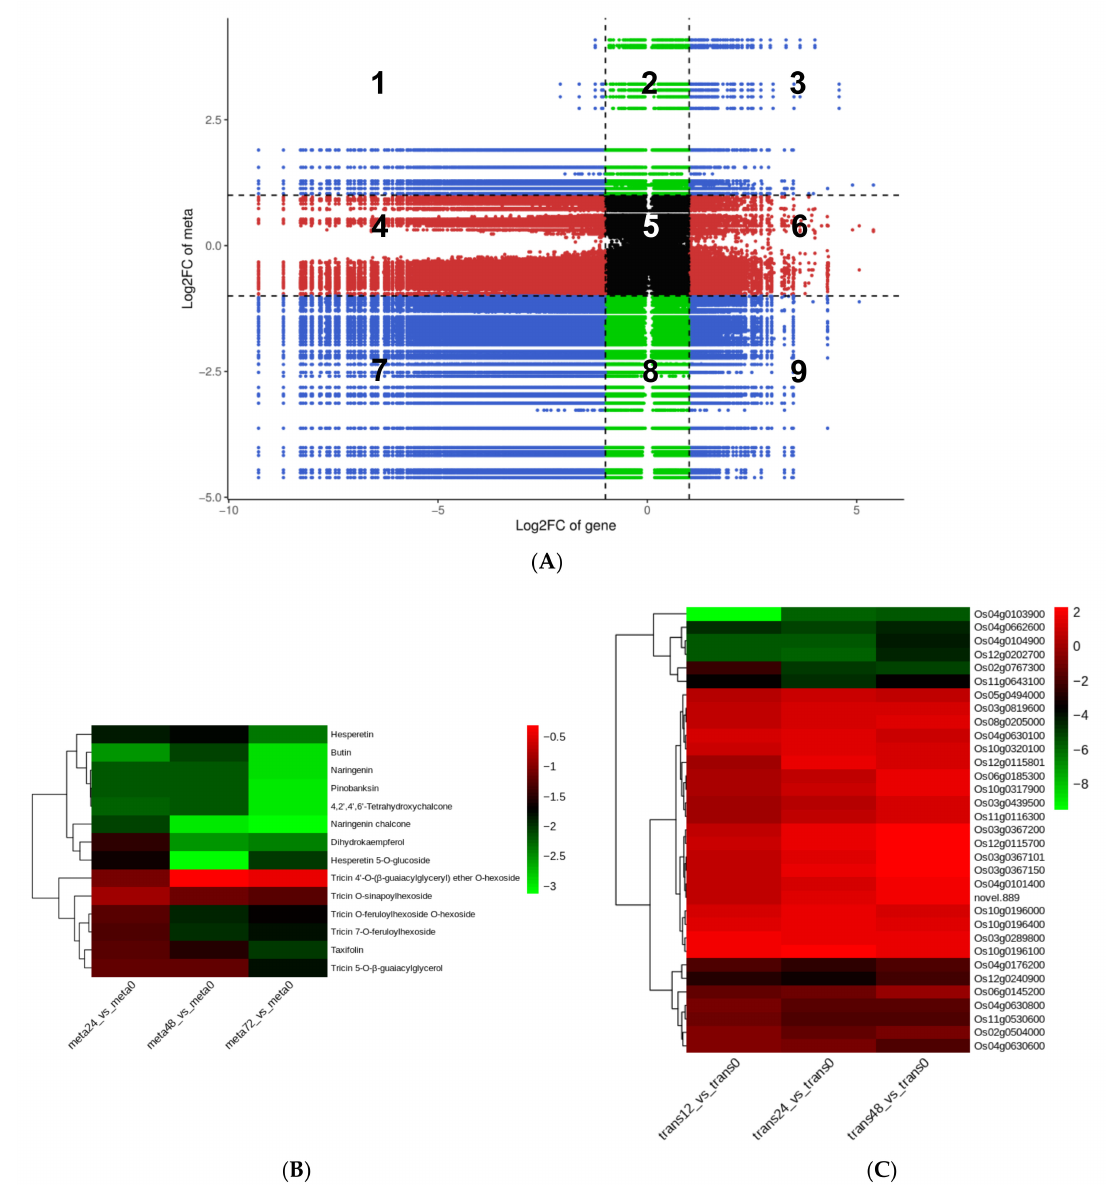
Figure 6. Correlation analysis revealing the potential regulatory network between DEGs and DAMs. ( A ) A nine-quadrant diagram showing the association of differentially expressed genes (DEGs) with differentially accumulated metabolites (DAMs) in the meta48-trans24 vs. meta0-trans0